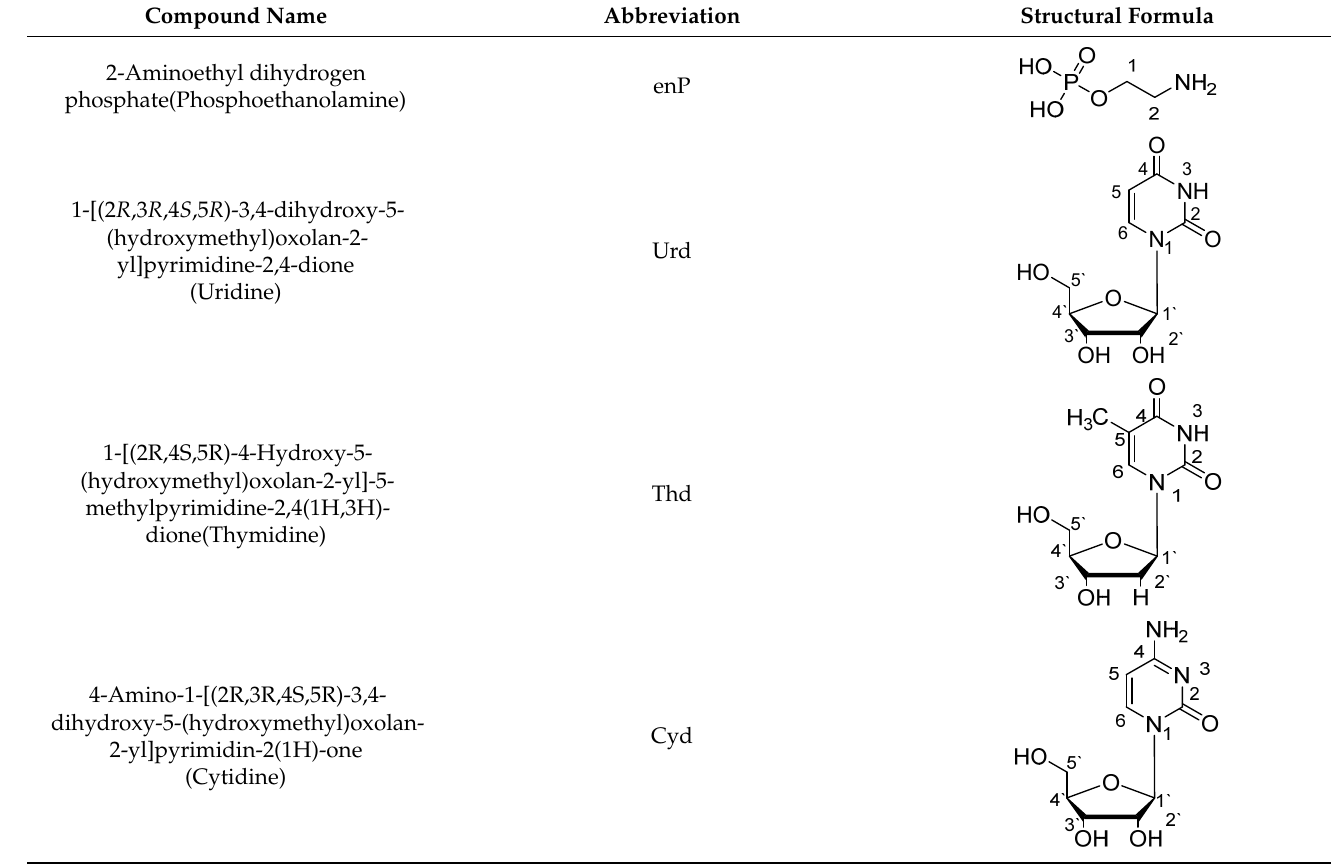
Table 1. The structures of phosphoethanolamine, uridine, thymidine and cytidine.